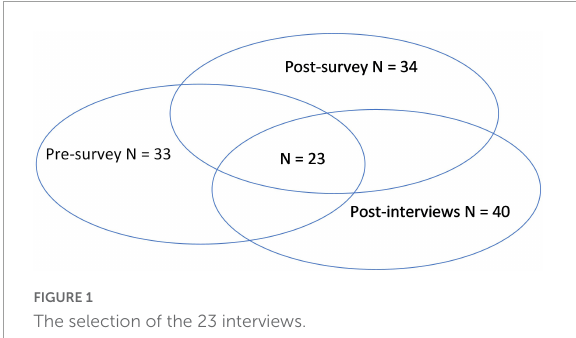
FIGURE1 The selection of the 23